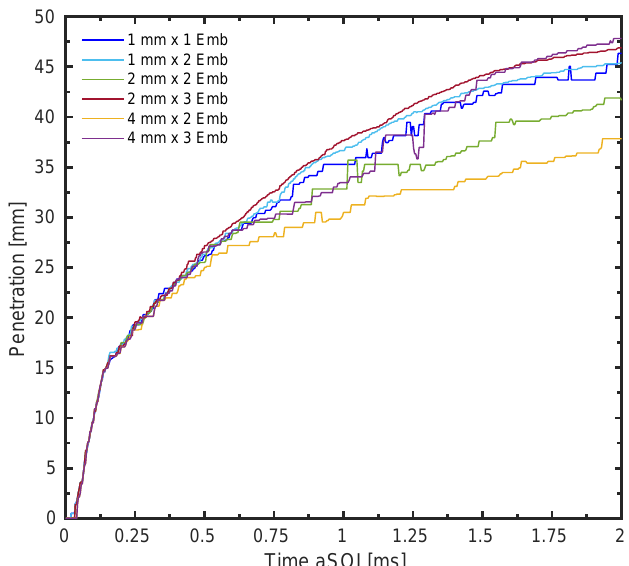
Figure 1. Effect of different mesh base and minimum cell sizes on the spray